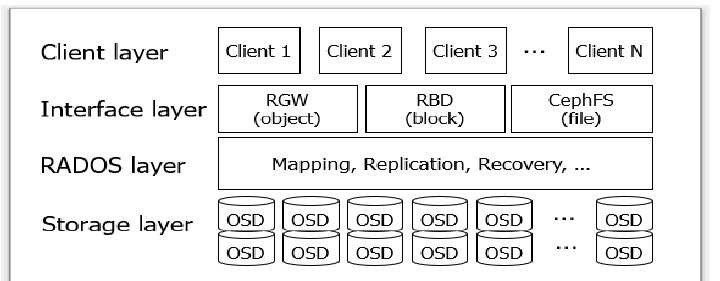
Figure 1. Ceph structure, which consists of four layers: client, interface, RADOS (Reliable Autonomic Distributed Object Store), and OSDs (Object Storage